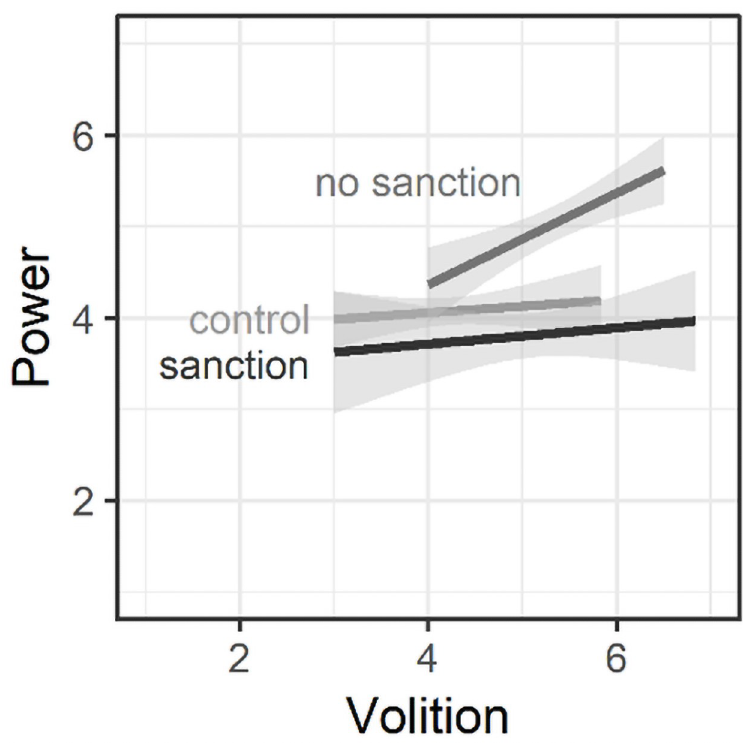
Fig 7. Simple slopes for the interaction of volition and sanctioning on power perceptions. The labels in the figure correspond to the following labels in Study 1: no sanction (non-sanctioned norm violator in Study 1), sanction (sanctioned norm violator), and control (non-sanctioned norm